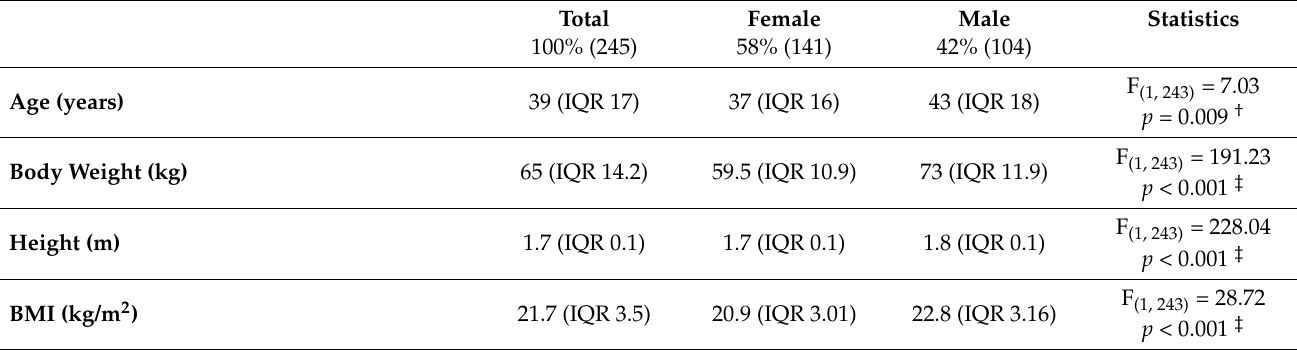
Table 1. Characteristics of Endurance Runners Displayed by